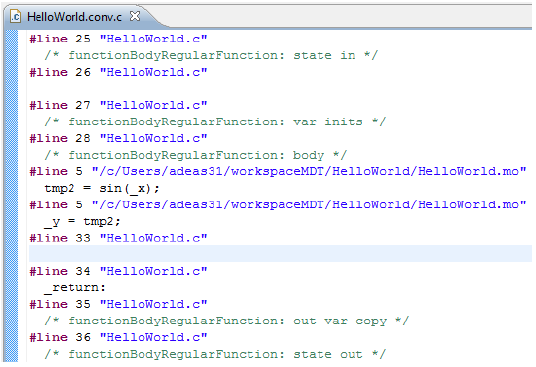
Figure 9: Converted C